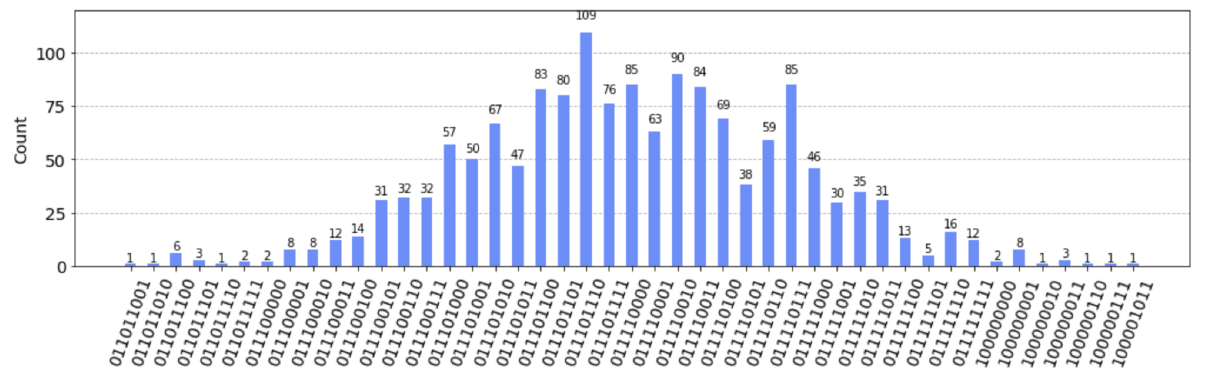
Figure 2. Output states of R(t) for u = 200, c = 20, m = 15, σ 2 = 4, t = 8.